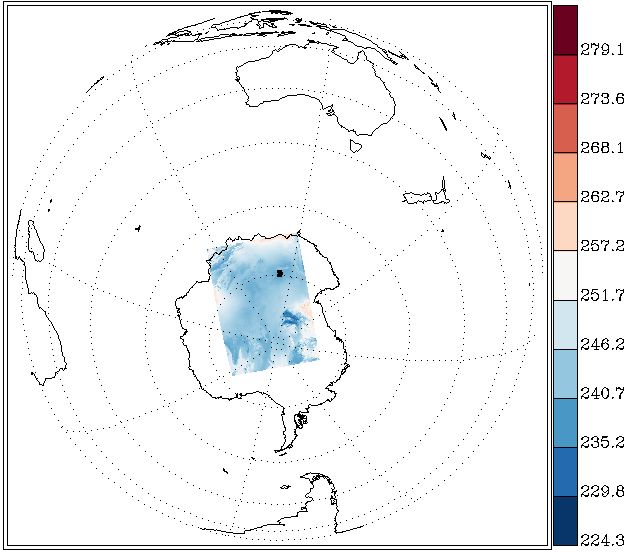
Figure 4. S-VIIRS Band M15 image illustrating the Antarctic EV location comprising the Dome C site.